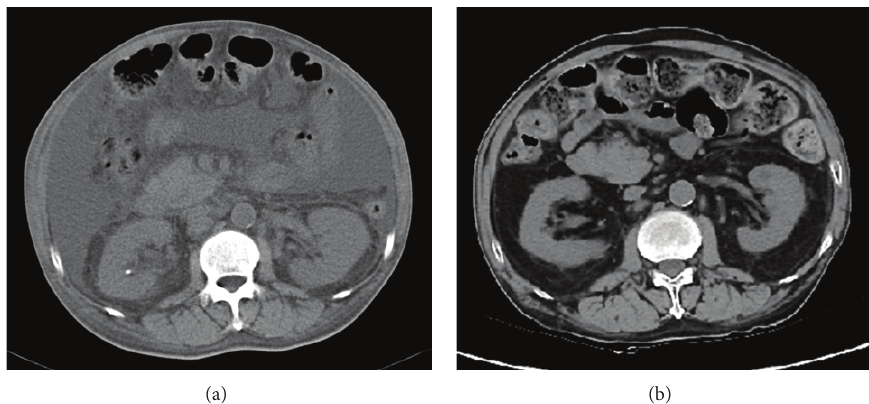
Figure 1: Computed tomographic scans of the abdomen. (a) Massive ascites before treatment. (b) Disappearance of ascites after treatment.